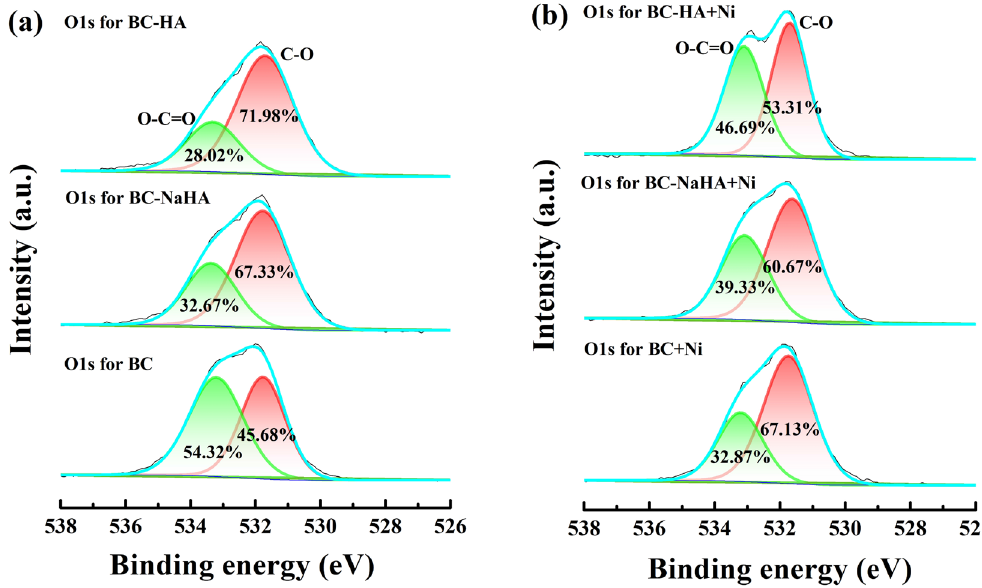
Figure 11. O1s high-resolution spectra ( a ) BC, BC-NaHA and BC-HA; ( b ) BC + Ni, BC-NaHA + Ni, BC-HA + Ni.